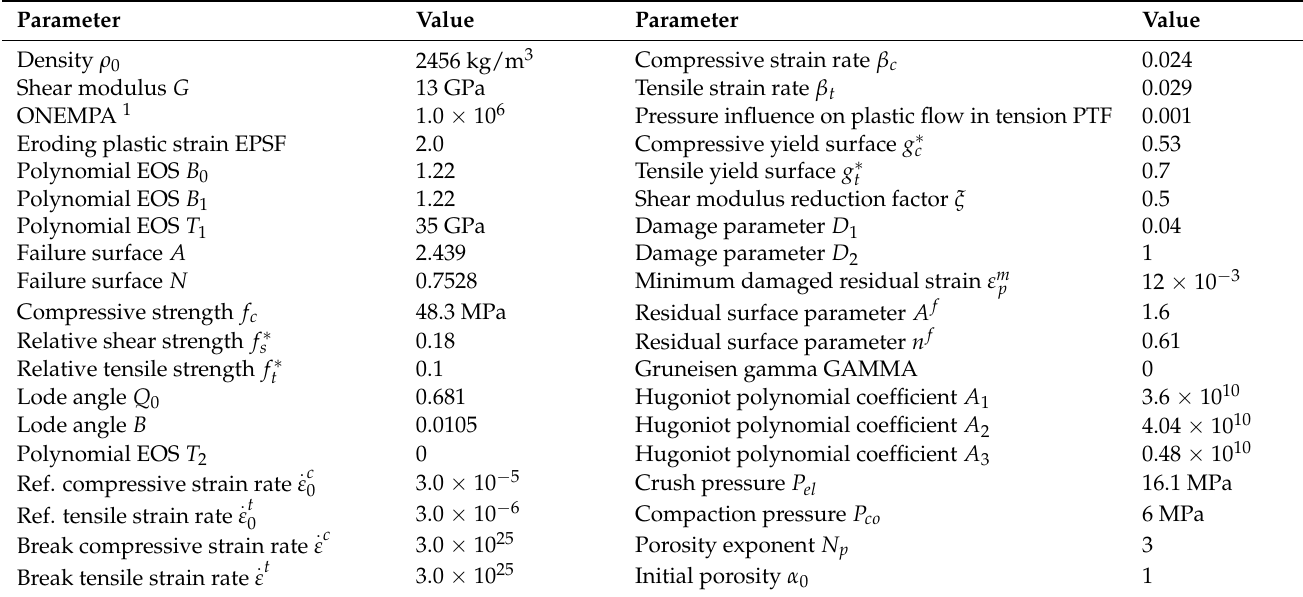
Table 2. RHT parameters for rock